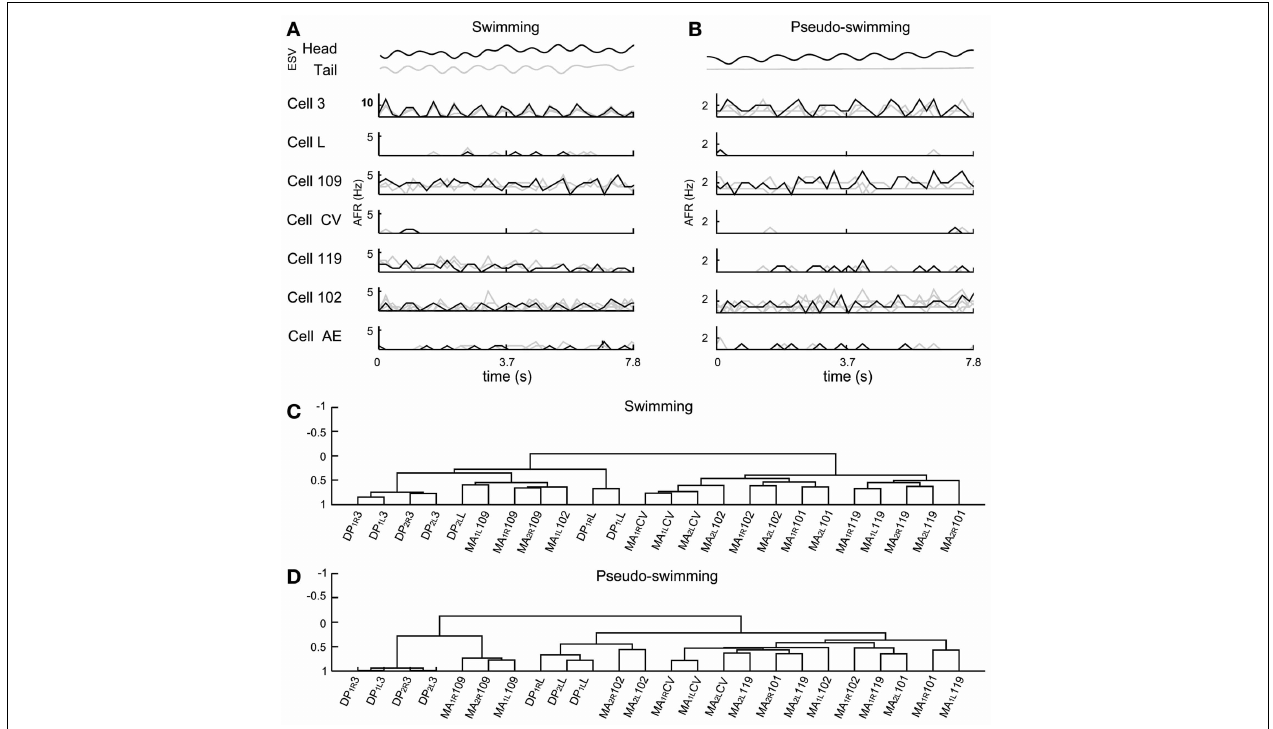
FIGURE 7 | Electrical patterns underlying swimming and pseudo-swimming. Episodes of swimming and pseudo-swimming obtained from a semi intact preparation which coincided in duration (7.8s). (A) Swimming episode. From top to bottom: head and tail elongation ( ESV in black and gray, respectively) and the firing rate from motoneurons 3, L, 109, CV, 119, 102, and AE. Extracellular recordings from four MAs and four DPs allowed the identification of four motoneurons for each